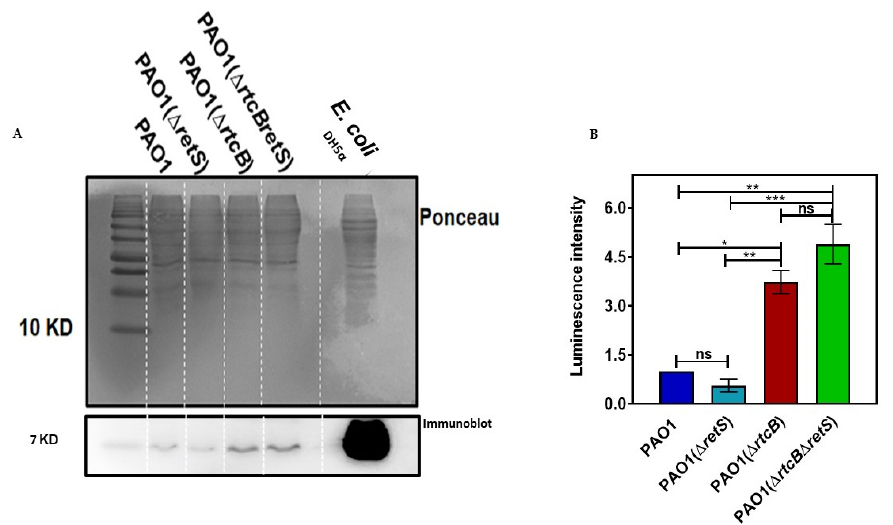
Figure 6. RsmA protein abundance was increased in PAO1( ∆ rtcB) and PAO1( ∆ rtcB ∆ retS), compared to their respective controls. ( A ) The total protein content of each strain was determined by Bradford assay, separated by SDS-PAGE, and probed with the E. coli CsrA antibody. Ponceau staining was used as a loading control. The RtcB deficient strain showed an increased content of RsmA compared with PAO1 and PAO1( ∆ retS ). ( B ) Densitometric analysis of the protein bands showed that the amount of RsmA in PAO1( ∆ rtcB ) and PAO1( ∆ rtcB ∆ retS ) was significantly increased. The luminescence intensity was measured with ImageJ software. Results are the average of three independent experiments. Data were analyzed using one-way ANOVA with Dunnette post-hoc test. ns p > 0.05, * p < 0.05, ** p < 0.01, and *** p < 0.001.